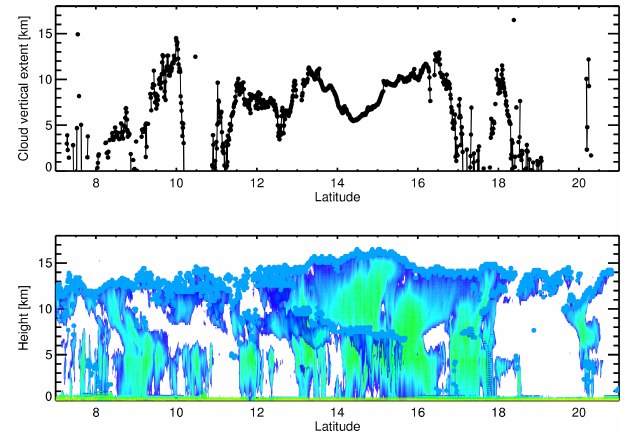
Figure 7. Cross section of hurricane Dean (17 August 2007). Top: estimated cloud vertical extent from FAME-C cloud heights. Bot- tom: radar reflectivity from CPR on CloudSat. The blue dots show the height of the most upper layer identified as cloud by the CPR cloud mask (>30). Note, cross sections from the Envisat and Cloud- Sat overpasses did not collocate in space and